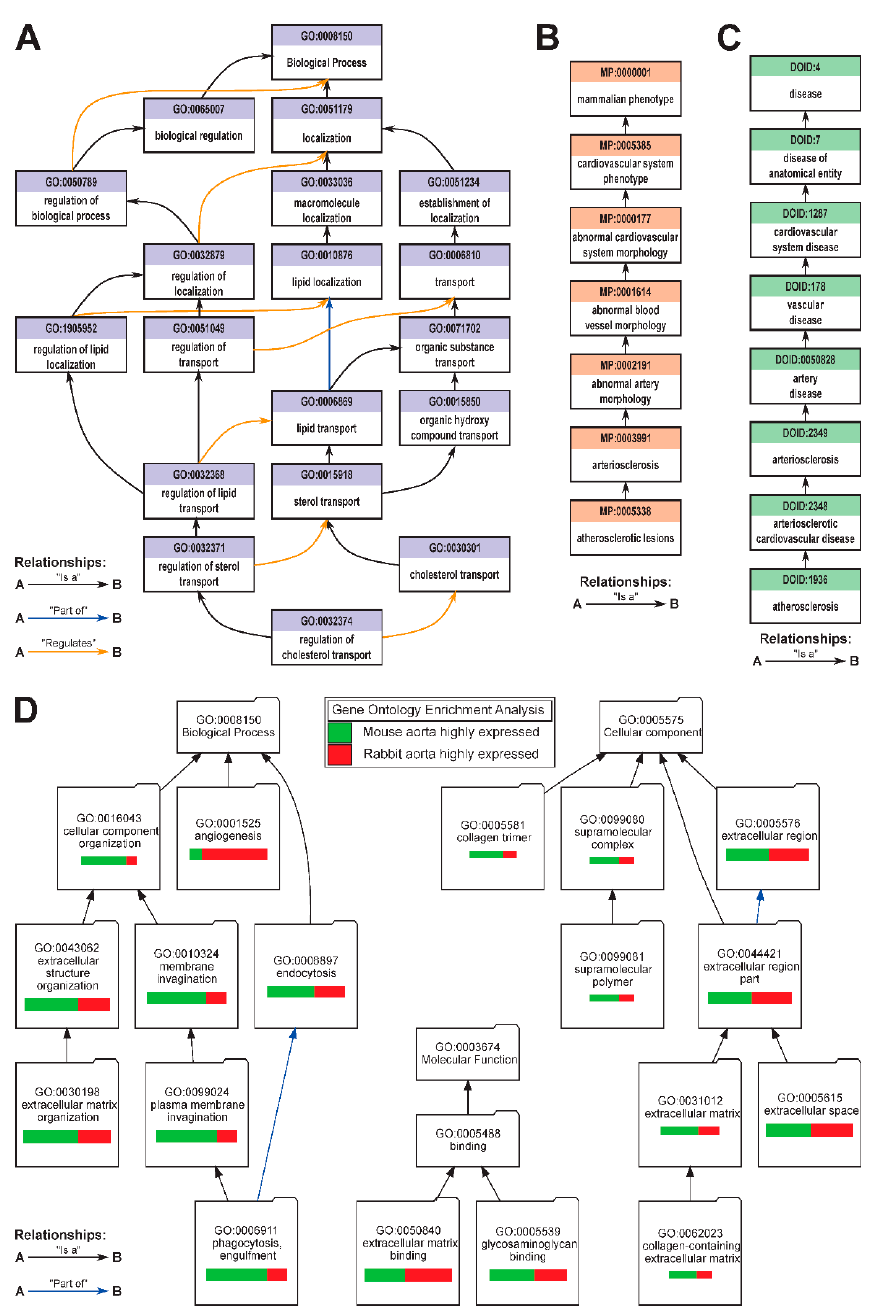
Figure 7. Examples of ontology structure and the power of ontological analysis. Gene Ontology (GO) ( A ), Mammalian Phenotype Ontology (MP) ( B ), and Human Disease Ontology ( C ) terms related to atherosclerosis. ( D ) Bioinformatics analysis result for VisuaL Annotated Display (VLAD) illustrating the statistically significant GO categories overrepresented among the 100 highest-expressed genes in atherosclerotic aortas of mouse and rabbit translational models. The width of the color bar represents the relative “strength” of a particular GO pathway representation among the highest-expressed genes and exemplifies similarities and differences between models, green bar = mouse, red bar = rabbit.